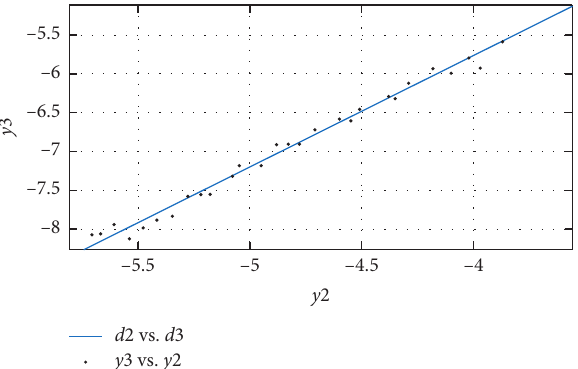
Figure 11: Approximate linear relationship between optimization objectives d